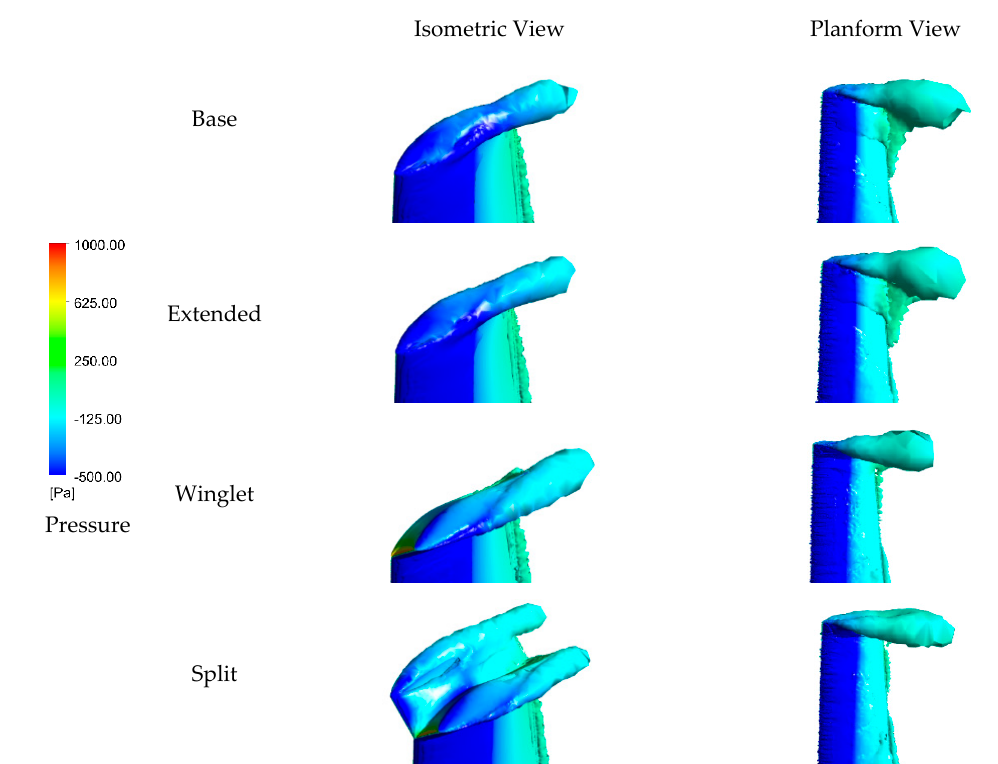
Figure 8. Vortices at the rotor blade tips at V = 11 m/s.